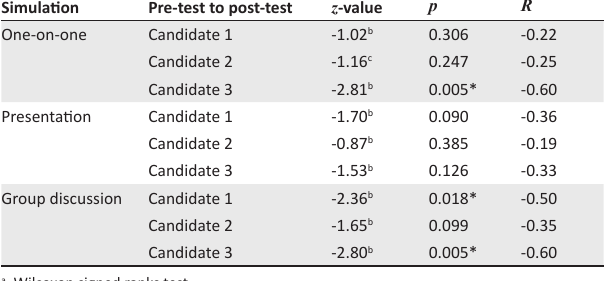
Experimental group: Pre-test